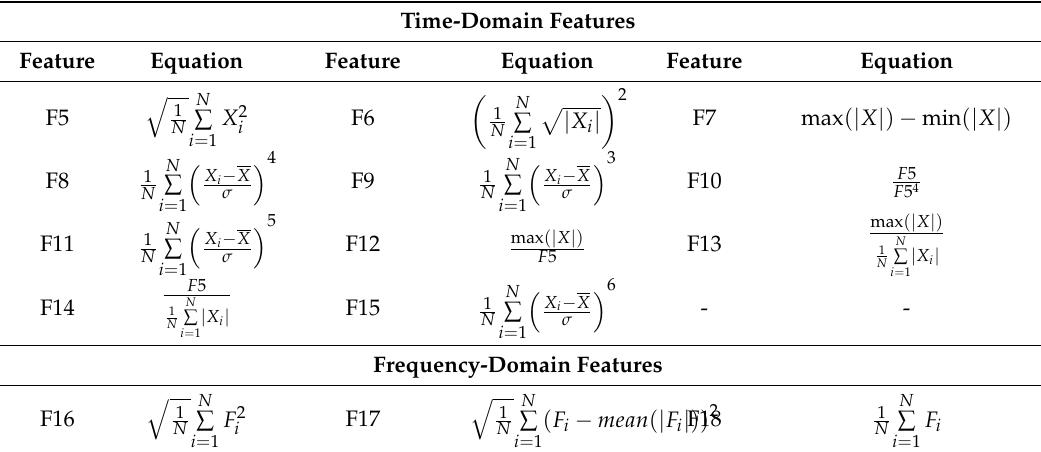
Table 2. Statistical features from time and frequency domains for the hybrid feature